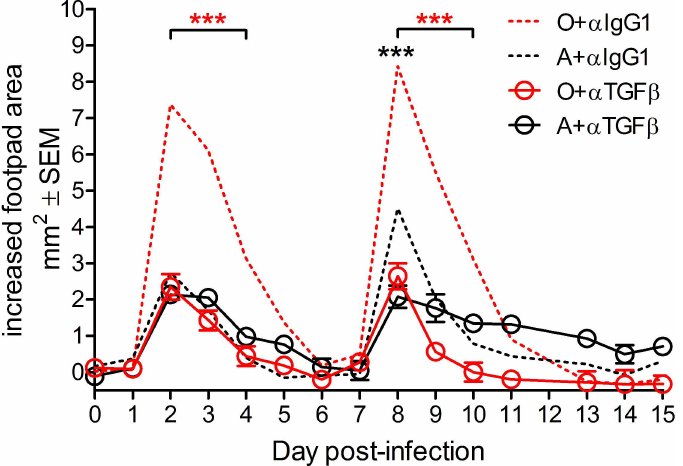
Fig 5. Blocking TGF β prevents acute CHIKV-induced disease in O mice. A and O B6 mice were inoculatedand treated with 100ug of anti-TGF β antibody or isotype control and swellingwas measured daily as describedin Methods. Data are mean ± SEM (n = 8 per group). Statistical significancewas determined using mixed model, repeated measures analyses of variance (ANOVA) as detailedin Statistics. Red stars indicate reduction of swellingin O mice from α IgG1 to α TGF β treated; black stars indicate reduction of swellingin A mice from α IgG1 to α TGF β